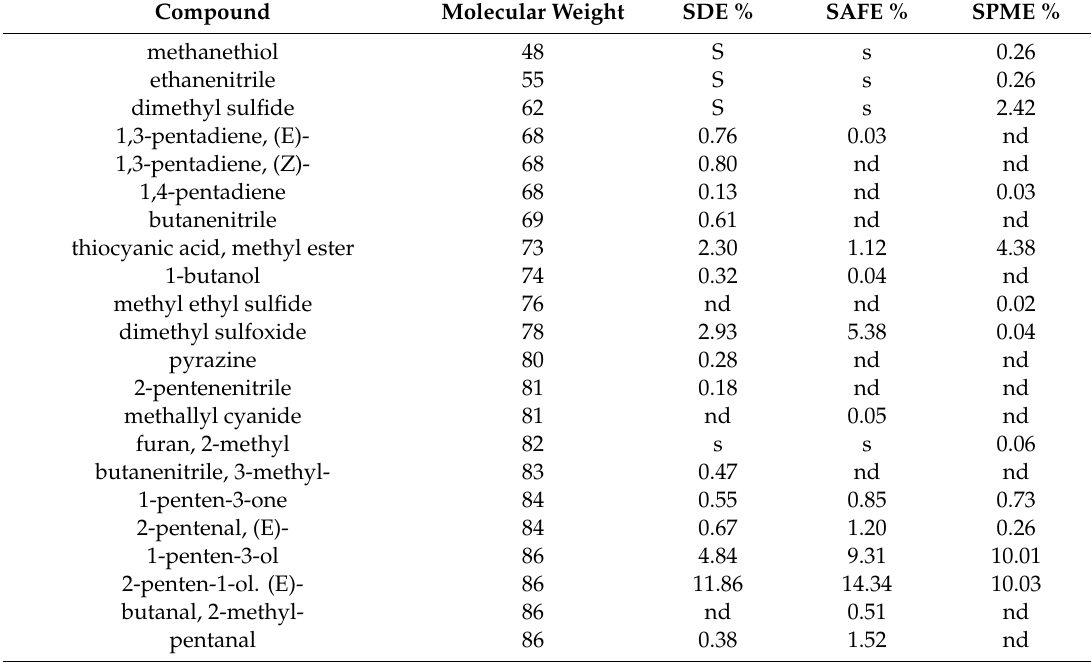
Table 2. Volatile compounds identified by GC × GC-ToFMS (tentative identification using NIST mass spectra library) from SAFE. SDE and SPME extracts. nd: not determined. Quantities expressed as percentage value using two decimal points. Compounds with peak area % > 0.01% shown. Compounds listed according to their increasing molecular weight